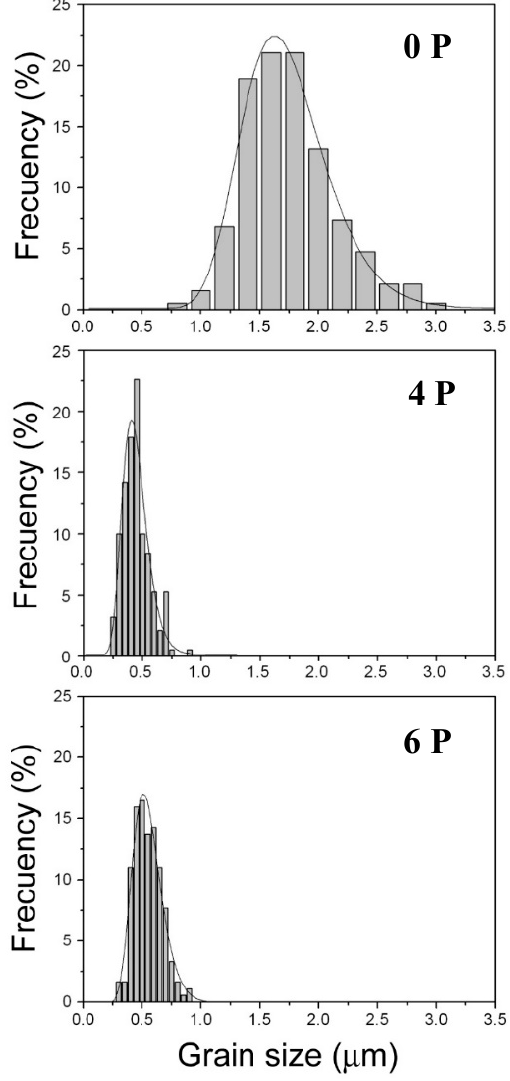
Figure 4. Histograms of grain size of the extruded GWZ31 alloy after 0, 4, and 6 ECAP passes. The orientation image mappings (OIM) of the magnesium grains (Figure 5a–e) and the {10 1(cid:3364) 0} pole figures obtained from the OIM image (Figure 6a–e) in the extruded alloy and after four and six ECAP passes reveal significant changes induced by the high strain introduced during the ECAP processing. In the case of the material after ECAP processing, two images were shown due to the